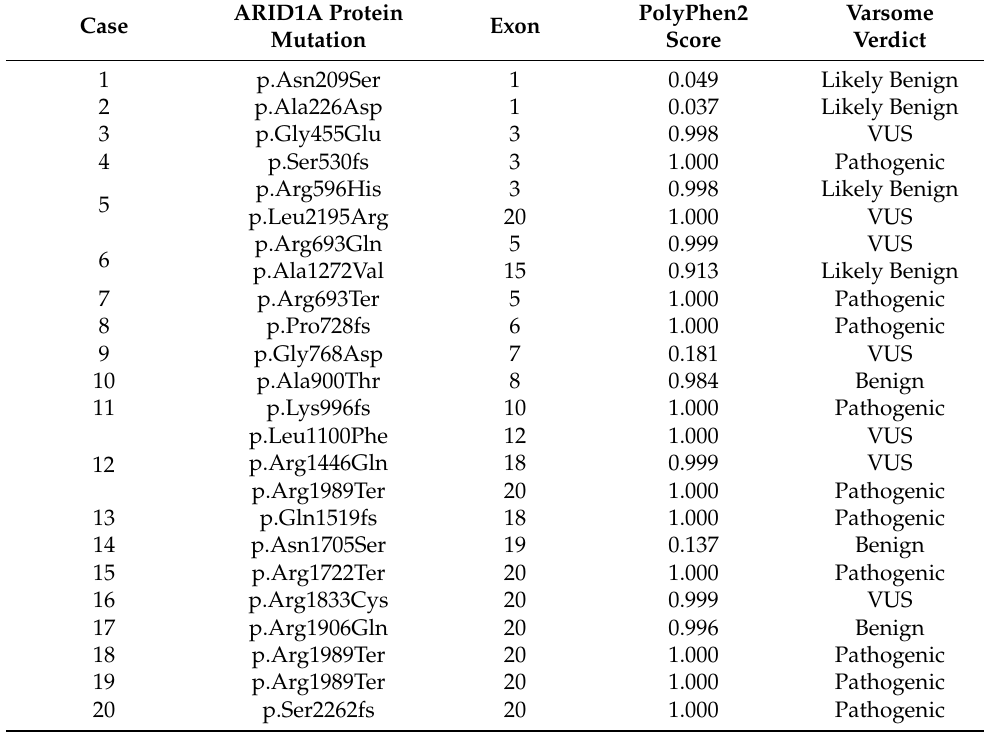
Table 2. ARID1A alterations observed in the analyzed cohort of ECs.